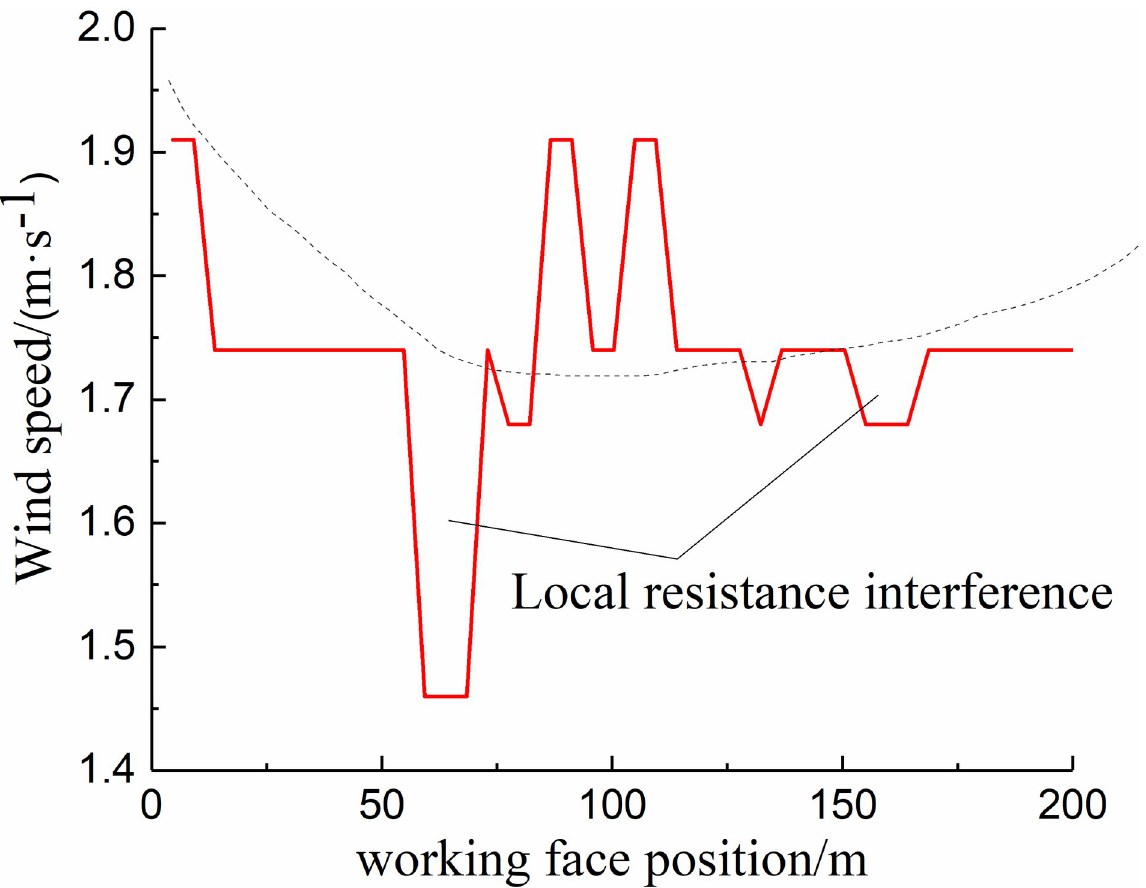
Fig 4. Observation and measurement results of wind speed along the 11101 working